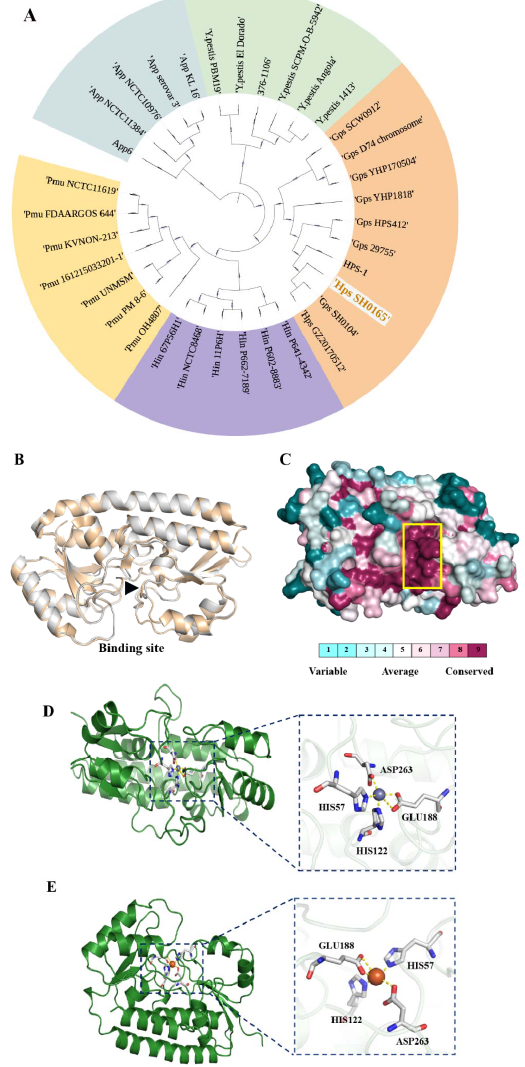
Figure 1. Bioinformatics analysis of YfeA. ( A ) Phylogenetic tree of YfeA . Neighbor-joining (NJ) tree demonstrated the overall diversity of YfeA from G. parasuis ( Gps or Hps , pink), Yersinia pestis (green), A. pleuropneumonia (blue), H. influenzae (purple), and P. multocida (yellow). ( B ) Comparison of YfeA protein structure between Y. pestis (white) and G. parasuis (gold). ( C ) Amino acid conser ‐ vation plots of YfeA protein analyzed by ConSurf. Based on the relative degree of conservation, each amino acid site was assigned a value from 1 (variable; light blue) to 9 (conserved; dark pur ‐ ple). A yellow box indicates the metal ion ‐ binding domain of YfeA. Schematic diagram of YfeA of G. parasuis binding with zinc ( D ) and iron ( E ). The gray sphere represents zinc; the orange sphere represents iron; the yellow dashed lines represent the metal complexation between the amino ac ‐ ids and metal ions.